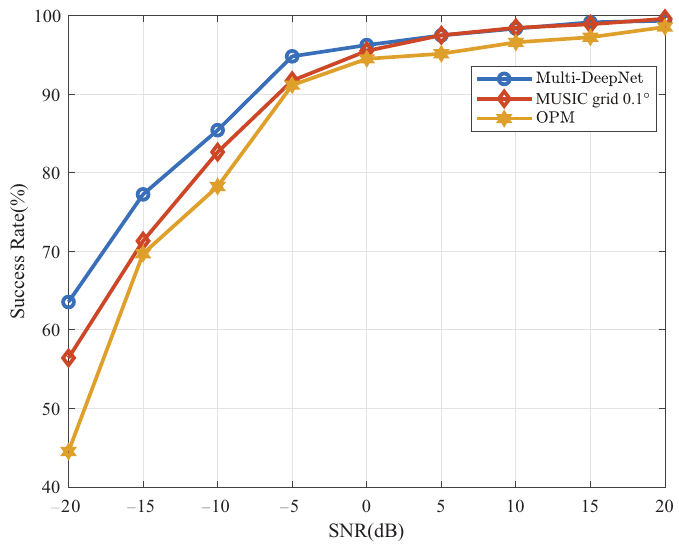
Figure 12. Success rate with